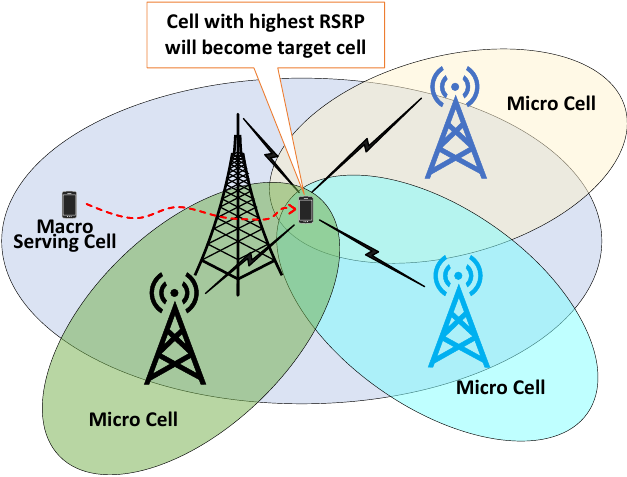
Figure 7. Basic illustration of RSRP based Handovers in